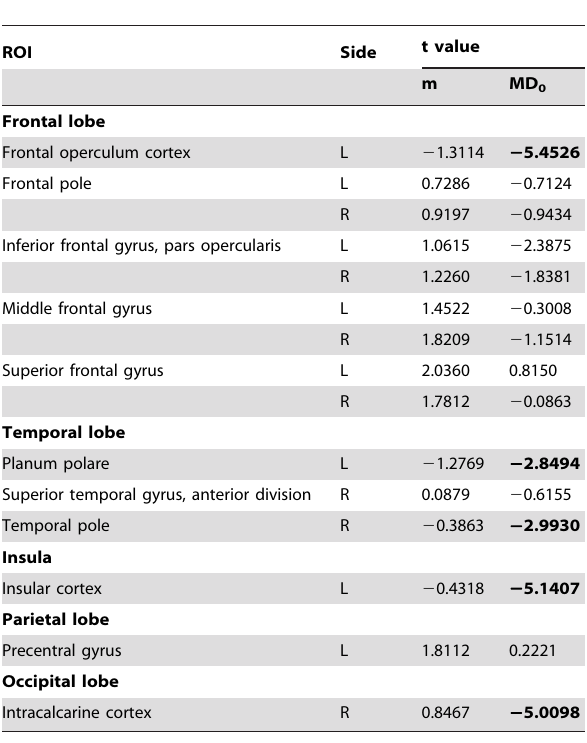
Table 5. Comparison between linear age-related trajectories of mean diffusivity in SZ and HC